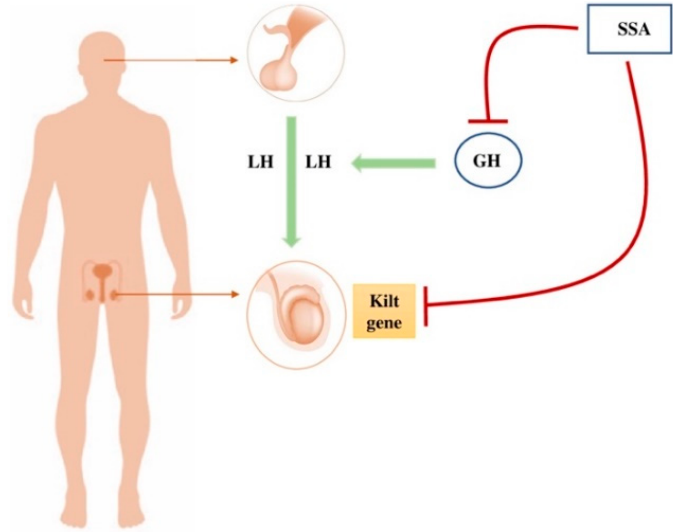
Figure 1. Hypothesis of SSA impact on male fertility. SSA could negatively impact spermatogenesis through two mechanisms. First, an inhibition of GH, and second, a dose-dependent RNA suppression of the kitl gene, involved in the spermatogenesis process. SSA = Somatostatin analogues; LH = Luteinizing hormone; FSH = Follicle-stimulating hormone; GH = Growth hormone.